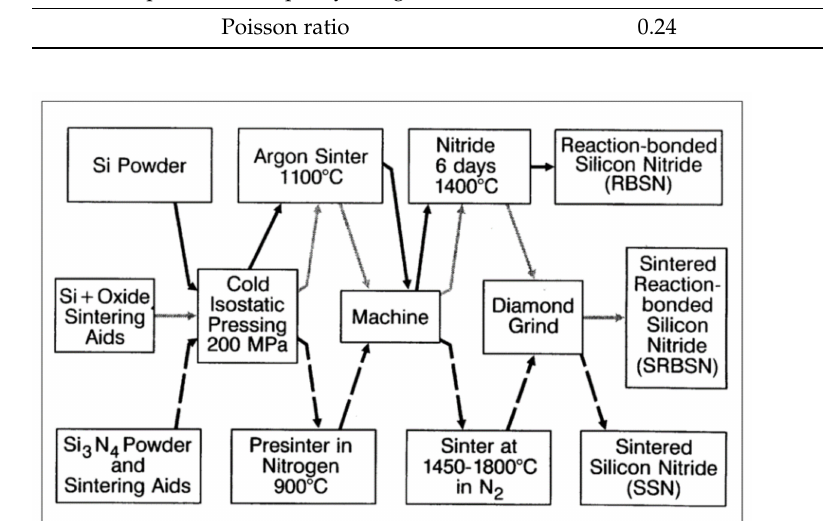
Figure 2. Processing routes to manufacture monolithic silicon nitride compacts [6,7]. © With permis- sion from